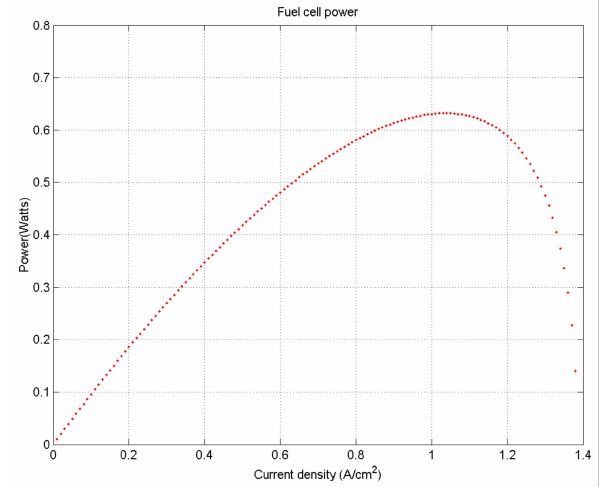
Figure 14. PEM-FC’s power.